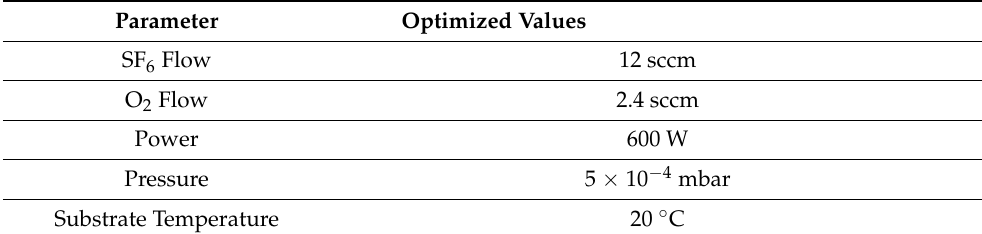
Table 4. Parametric analysis: optimized parameters.